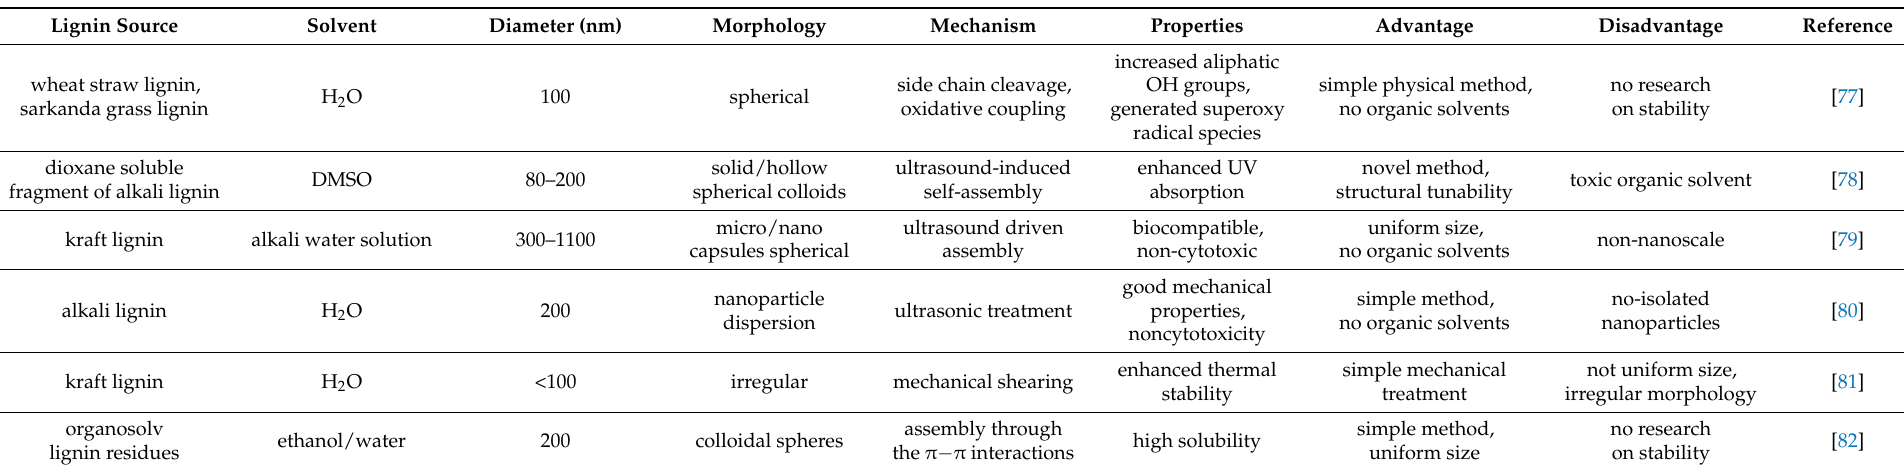
Table 4. Preparation of Lignin Nanoparticles by Ultrasonication and